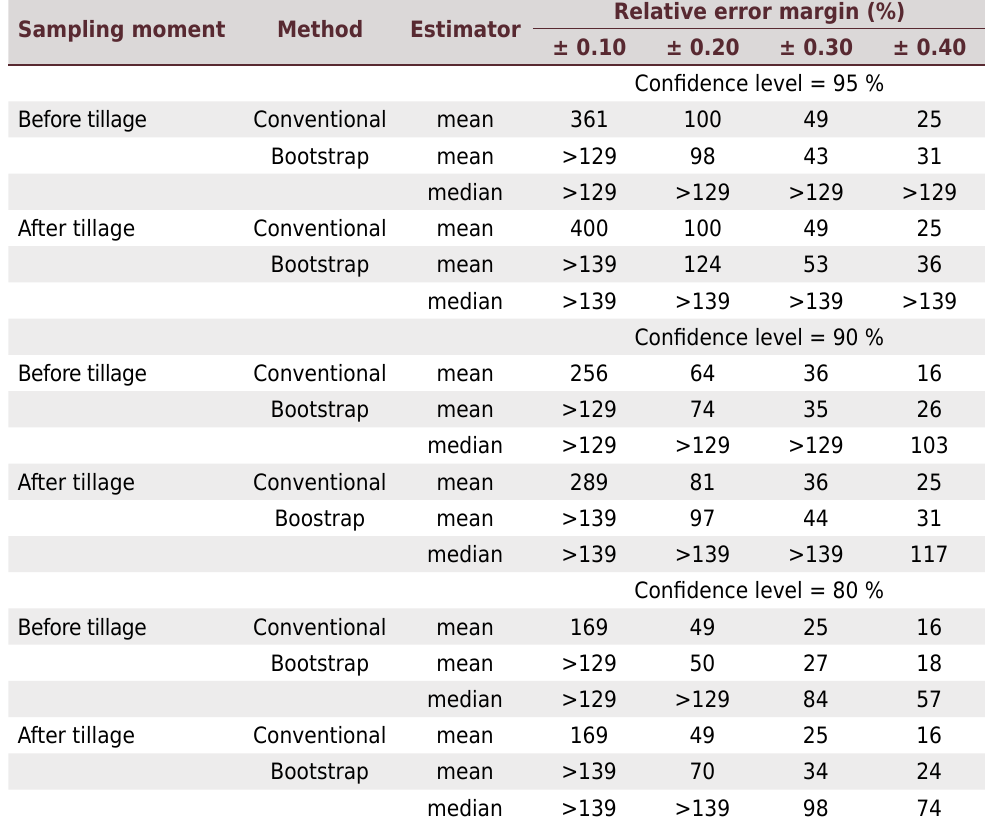
Table 3. Minimum sample sizes needed to estimate the vertical profile of mean cone index (CI) values with different levels of precision and confidence before and after soil tillage determined by conventional and bootstrap methods, using the vertical profile of sample mean and median values as estimators Sampling